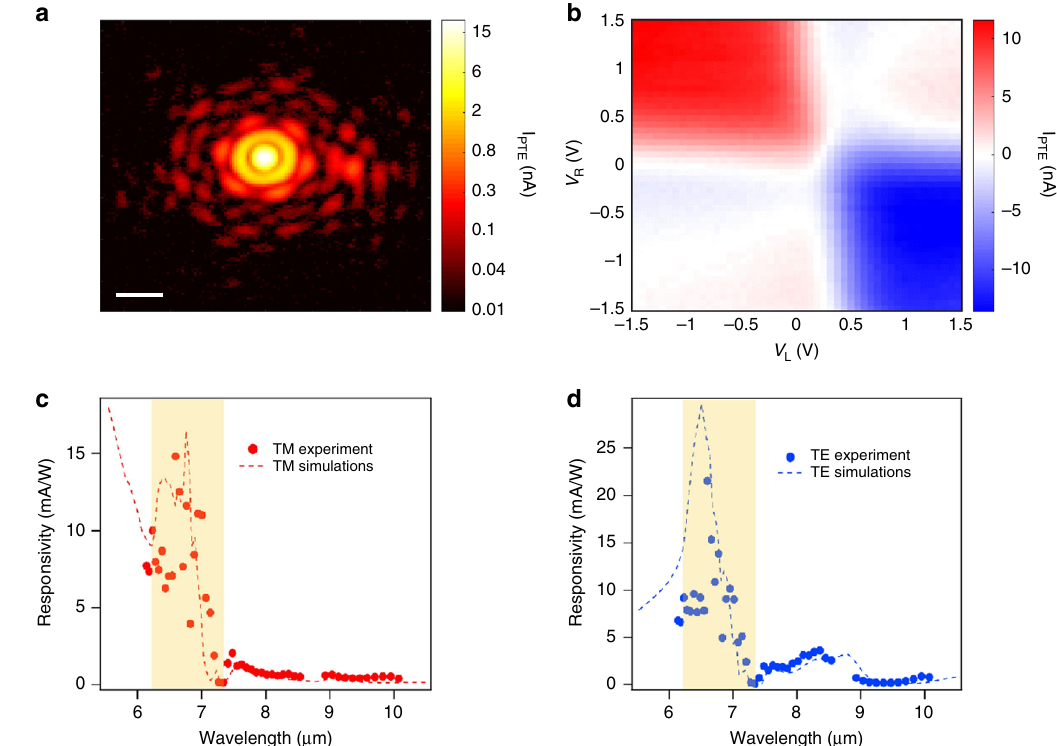
Fig. 2 Photocurrent generation and spectral photoresponse. a Scanning photocurrent map (log scale) across the mid-IR beam focus at λ = 6.6 μ m. The white scale bar corresponds to 20 μ m. We obtain a FWHM of 6.1 μ m. We use a small input power ( P in ) of 13.7 μ W (irradiance of 0.2 μ W/ μ m 2 ). b Photocurrent map as a function of the two gate voltages at λ = 6.6 μ m. c Experimental (dots) and theoretical (dashed lines) spectral external responsivity of the device for TM-polarization and ( d ) for TE-polarization. The highlighted region corresponds to the hBN RB ( λ = 6.2 – 7.3 μ m). For ( c and d ), we set the gate voltages to a pn-junction con fi guration close to the optimal with V L = 0.5 V (97 meV) and V R = − 0.5 V ( − 100 meV). We use the same doping level for the theoretical